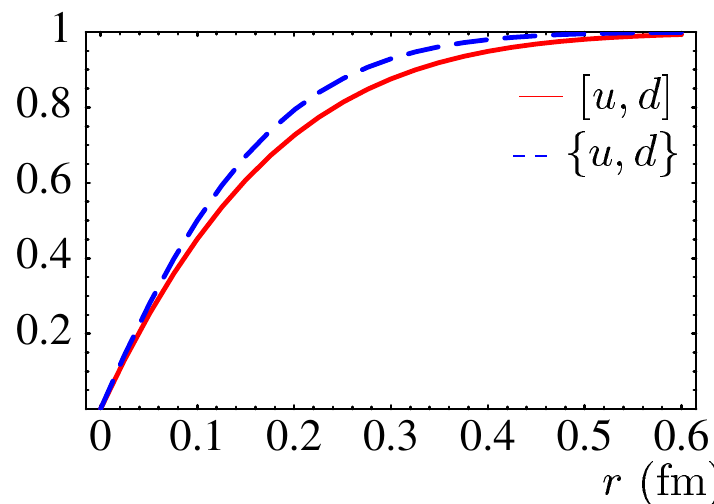
Figure 1. The form factors F ( r ) for the scalar [ u , d ] (solid line) and axial vector { u , d } (dashed line)